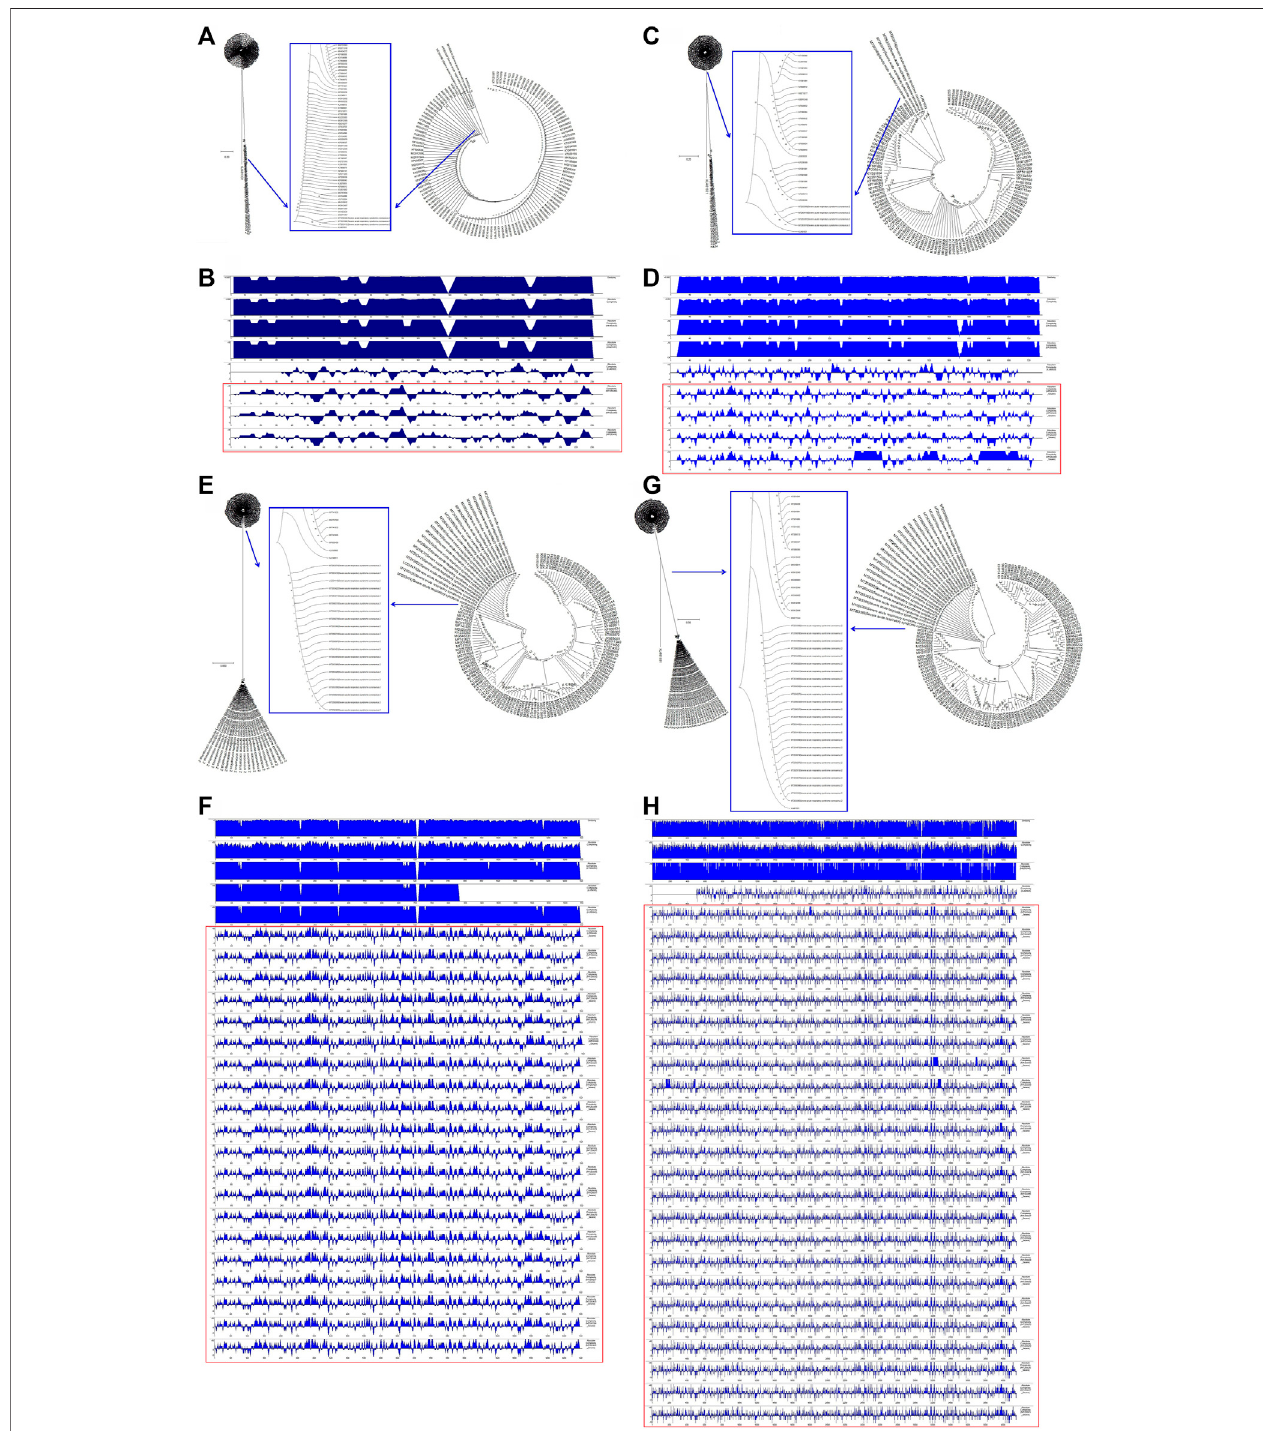
FIGURE 3 | Evolutionary characteristics and absolute diversity of structural genes in severe acute respiratory syndrome coronavirus-2 (SARS-CoV-2) isolates and common coronaviruses (C-CoVs) that infect humans. (A) : The E gene sequences of SARS-CoV-2 isolates were evolutionary intermediates between KJ481931 and MG011357. (C) : The M gene sequences of SARS-CoV-2 isolates were evolutionary intermediates between KJ48193 and a group of C-CoVs (KP209309, KY581691, KY581689,KY581686, KP209307,KP209313,andKP209306). (B,D) :TheabsolutediversitiesoftheEandMgenesequenceswithintheKJ481931C-CoVwere similartothoseoftheEandMgenesequences ofSARS-CoV-2 isolates. (E,G) :TheNandSgenesequencesofSARS-CoV-2isolateswereevolutionarilydistinct. (F,H) : The absolute diversities of the N and S gene sequences of SARS-CoV-2 isolates differed from those of all C-CoVs that infect humans.